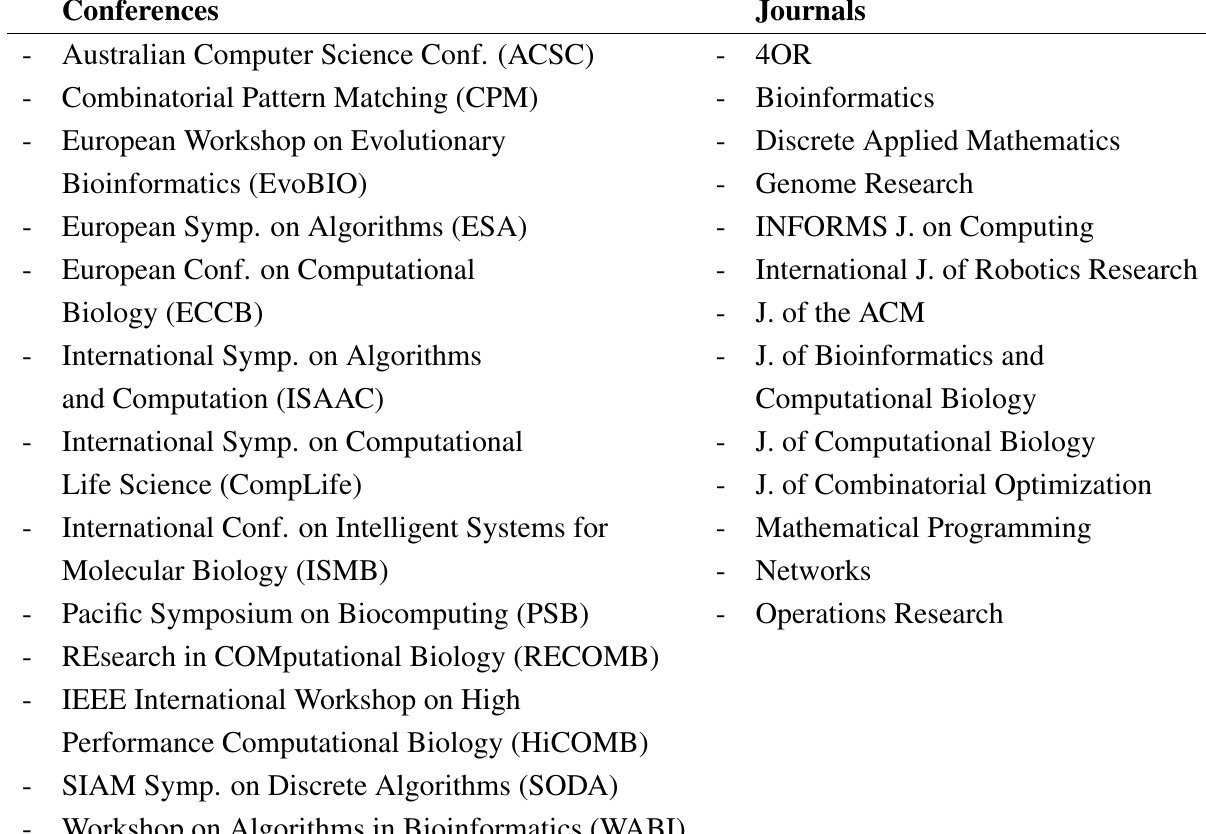
Figure 1. Conferences and journals publishing MP papers in